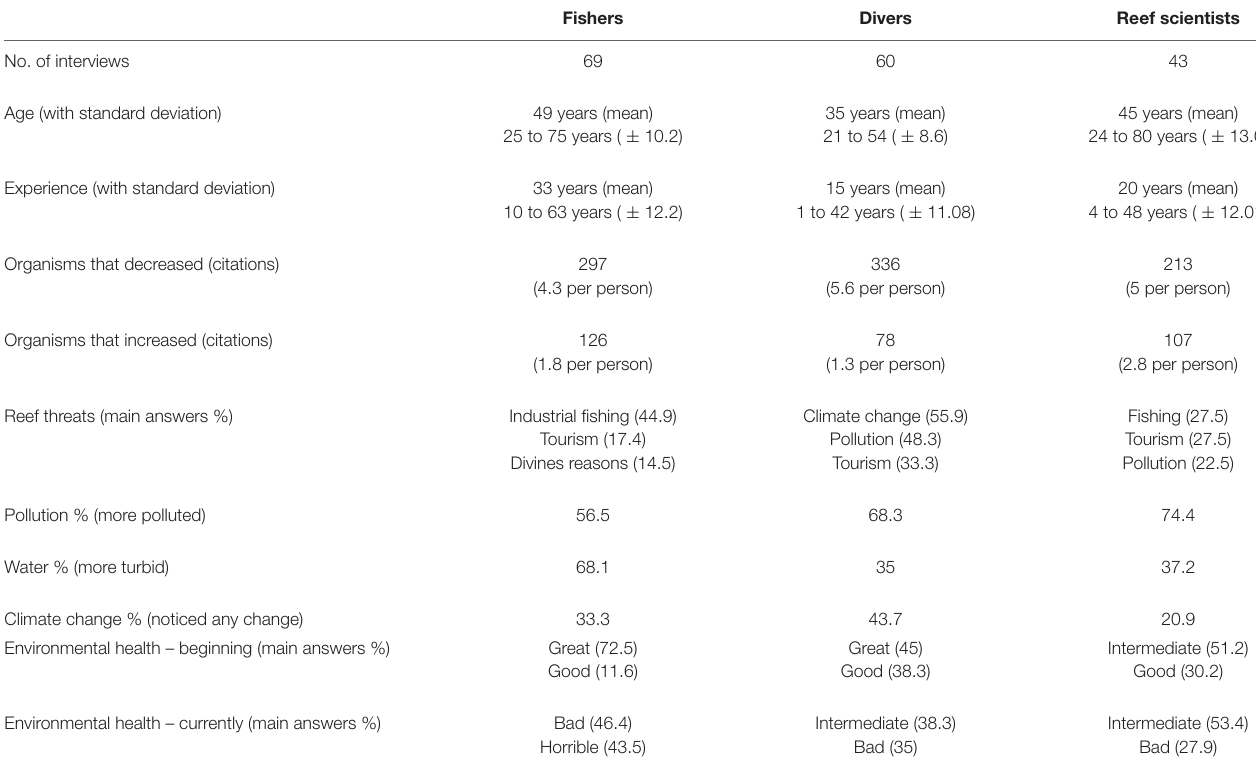
TABLE 2 | Main qualitative results according to the interviewed stakeholders (fishers, reef scientists, and divers).